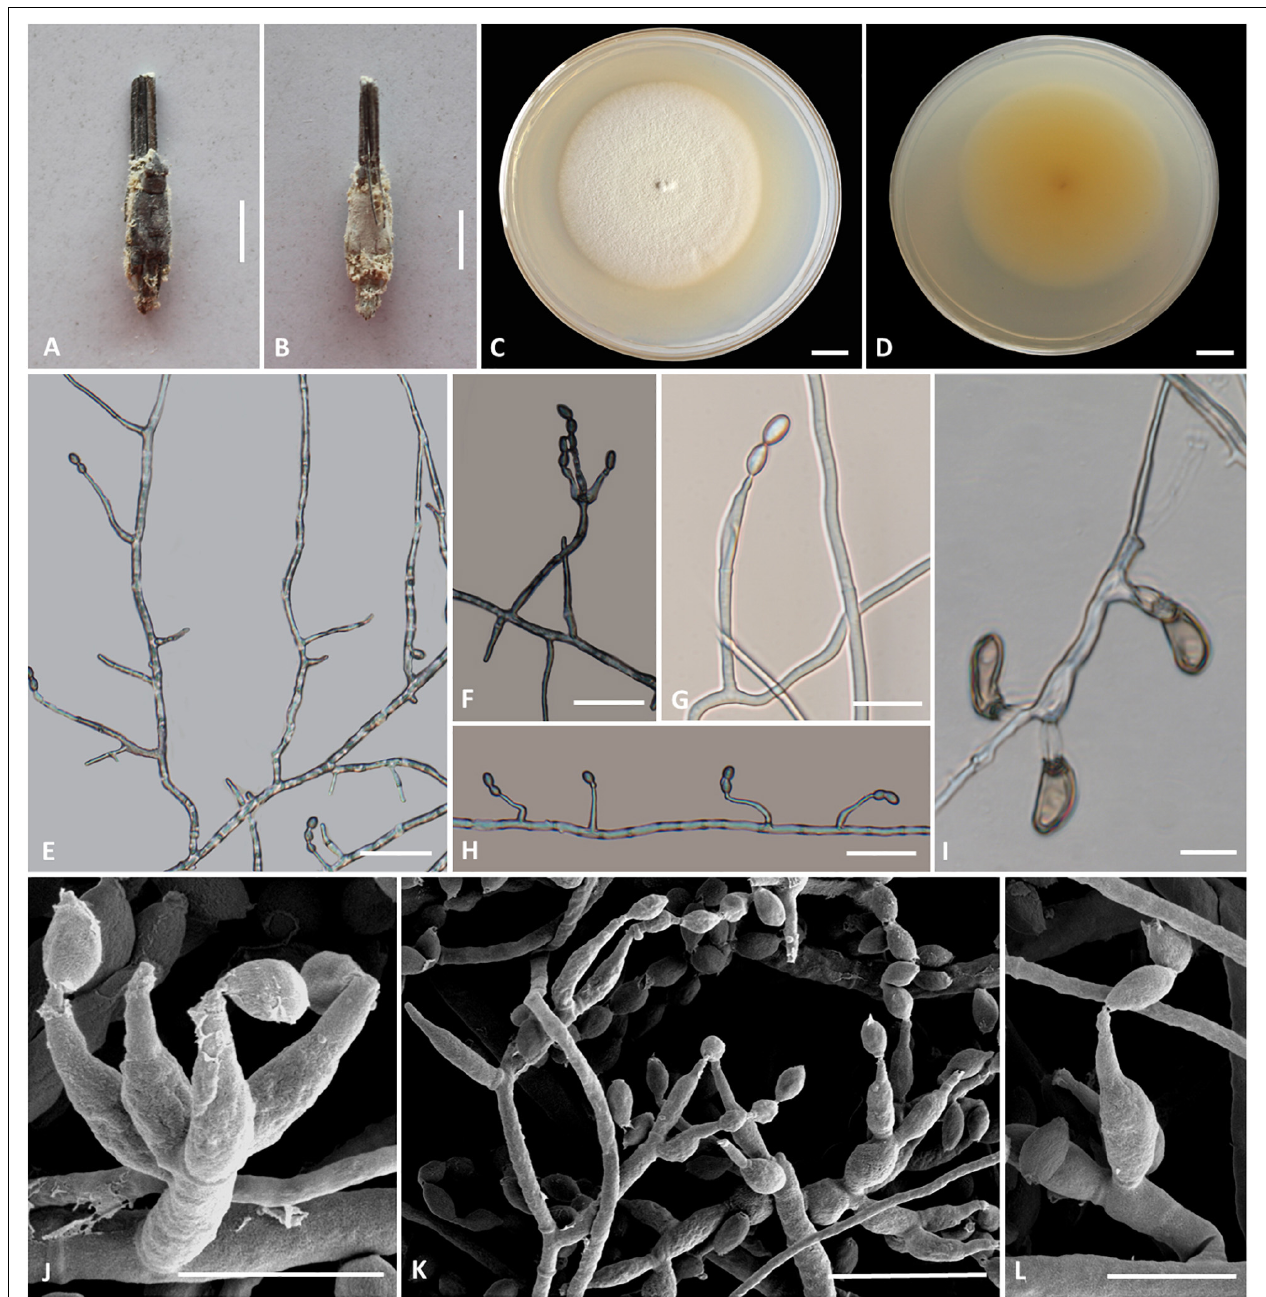
FIGURE 5 | Cordyceps pseudotenuipes. (A,B) Fungus on the host of Coleopteran. (C,D) Colony obverse (C) and reverse (D) on PDA at 14 days. (E,G,H,L) Solitary phialides on hyphae. (F,J,K) Conidiophore and verticillate phialides. (I) Chlamydospore. Scale bars: (C,D) = 5 mm; (E,F,G) = 25 µ m, (H,I) = 20 µ m; (J,L) = 5 µ m; (K) = 10 µ